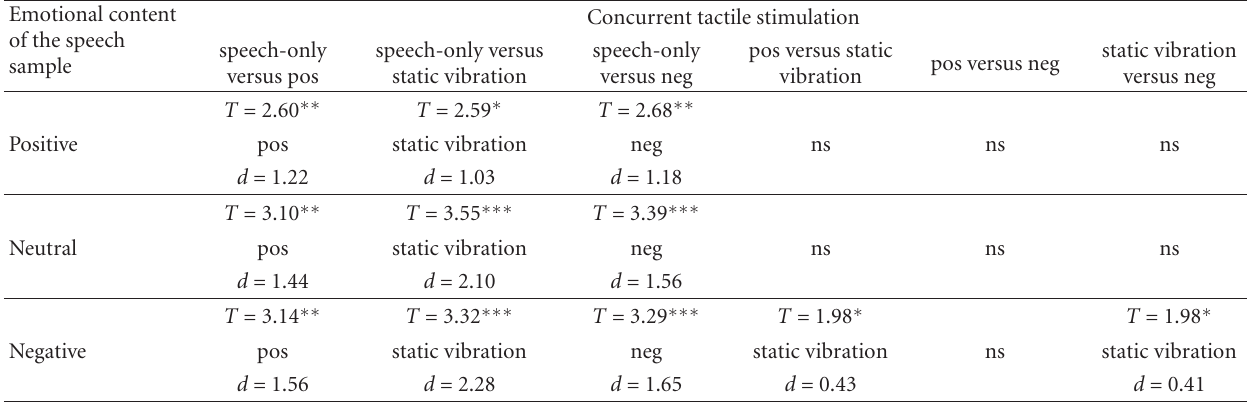
Table 5: Pairwise comparisons between the concurrent tactile stimulation categories within each of the speech samples used. In the table the tactile stimulation derived from positive speech sample is referred as pos and the tactile stimulation derived from negative speech sample as neg.